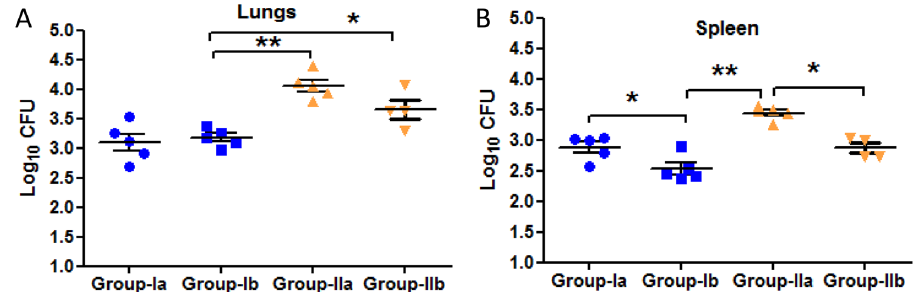
Figure 5. CFU comparison between untreated and treated groups. Log 10 CFU counts in lungs and spleen of untreated and INH + RIF treated latent tuberculosis and latent tuberculosis with diabetes group ( A ) Lungs ( B ) Spleen. The data were represented as Mean ± SE of 5 animals in each group and the statistical significance was determined by Mann–Whitney test. *p ≤ 0.05. Group-Ia: latent tuberculosis untreated, Group-Ib: latent tuberculosis treated with INH + RIF, Group-IIa: latent tuberculosis with diabetes untreated, Group-IIb: latent tuberculosis with diabetes treated with INH + RIF. Animal model was developed only once but CFU enumeration was done in triplicates from each animal.